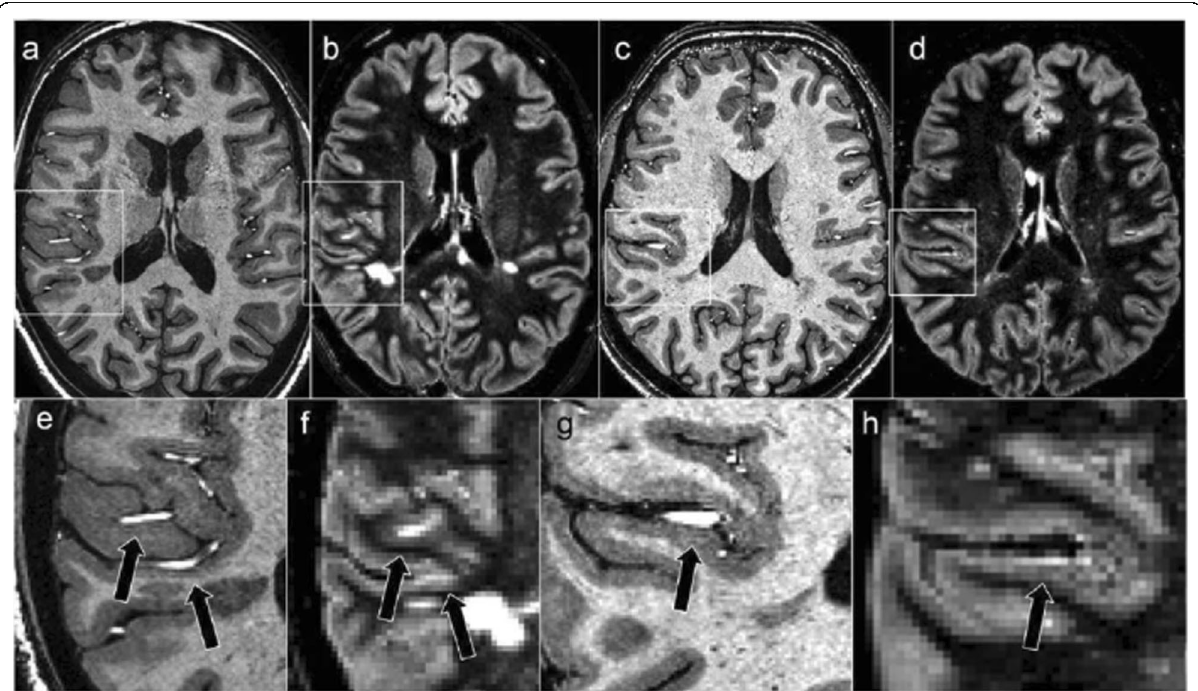
Fig. 1 Cortical lesions and artefacts. Two hyperintensities misinterpreted as cortical lesions on a 3-T double inversion recovery images ( b – f ), are de facto extracranial vessels, as demonstrated on 7-T magnetisation-prepared rapid gradient echo images ( a – c ). Magnified versions of the images are also shown ( e – h ). Published with permission from J Magn Reson Imaging